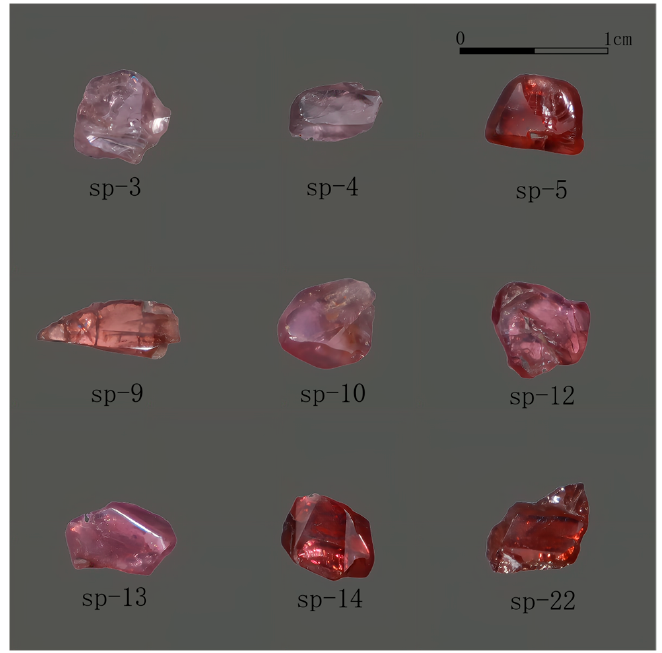
Figure 1. Some spinel samples under D65 light source.